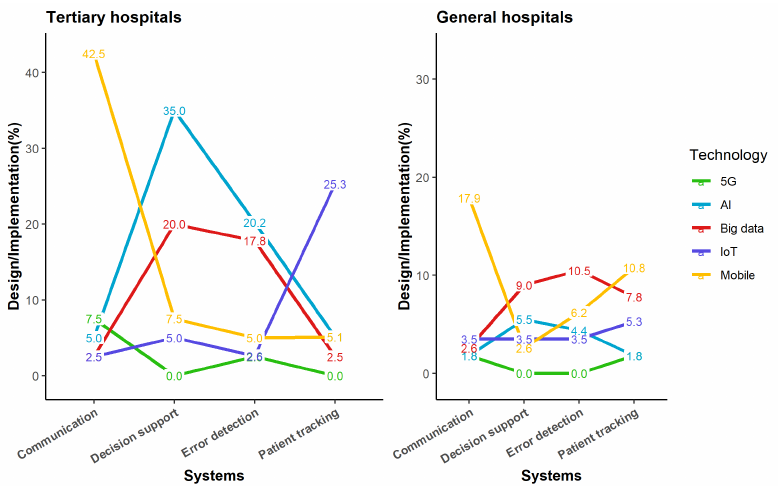
Figure 5. Status of core technology-based systems and/or services Abbreviations: 5G, 5th generation mobile communication; AI, artificial intelligence; IoT, internet of